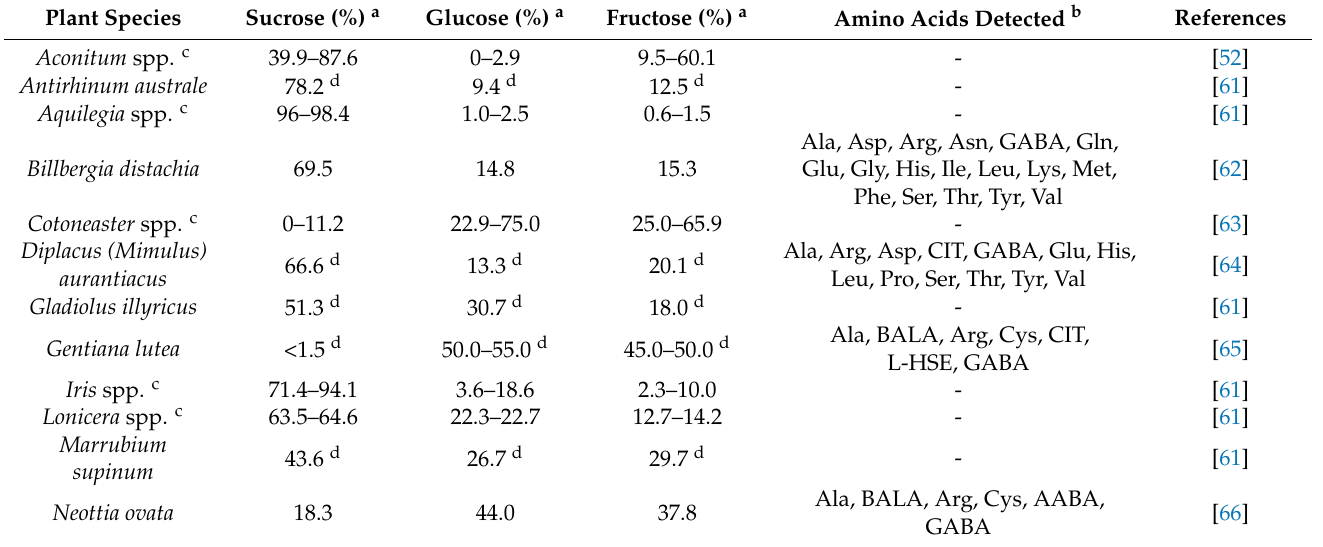
Figure 1. Yeasts in flower nectaries ferment sugars, metabolize amino acids, and produce VOCs that might alter insects’ behavior. When these invertebrates feed on nectar, pollen is transported from anthers to the stigma (which may happen between different individual plants or between both parts in the same flower). Then, pollen germinates, and the pollen tube emanates, eventually allowing fertilization. Table 2. Nectar composition of different angiosperm